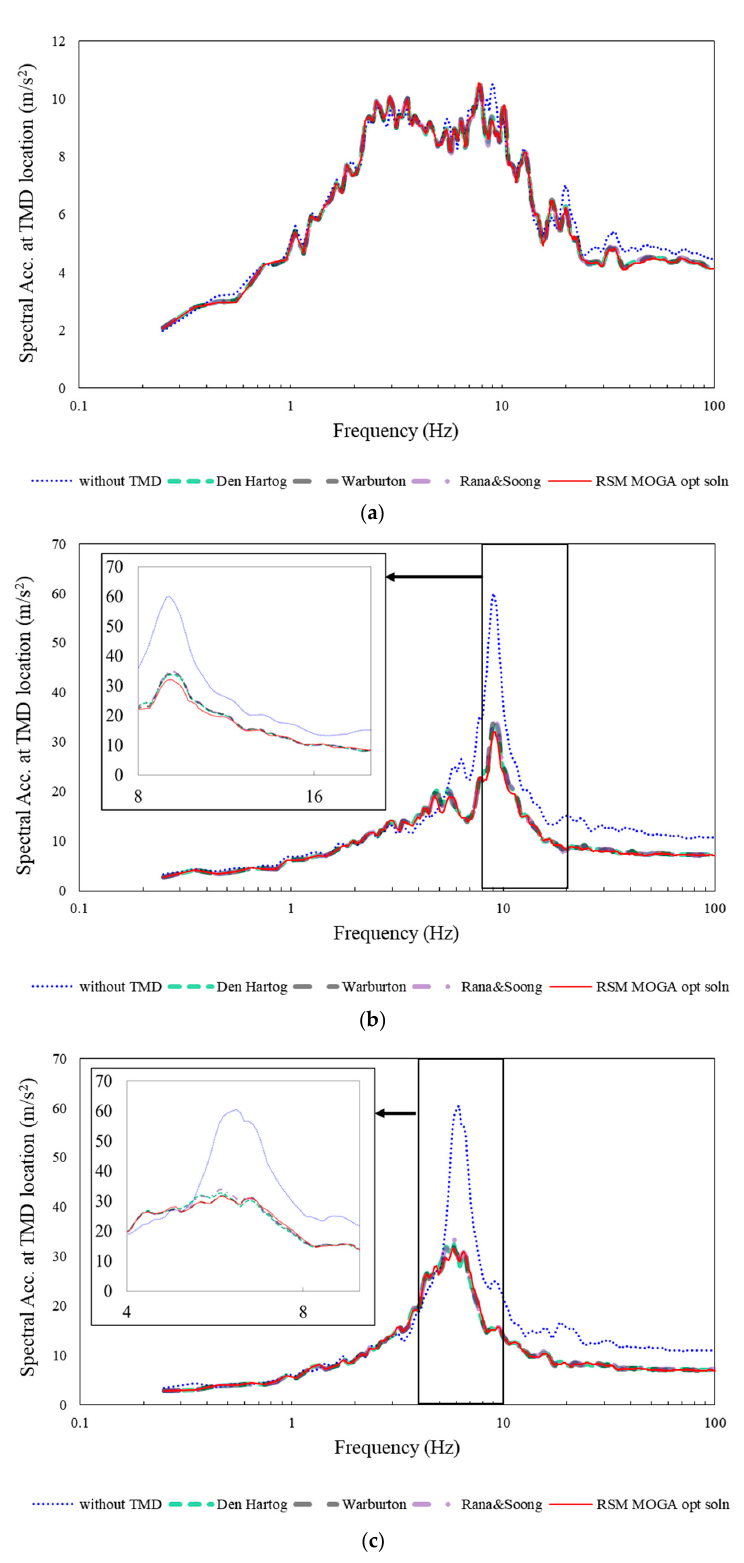
Figure 12. Comparison of the response spectra of directional acceleration responses at the TMD installation location of the piping: ( a ) X-direction spectrum (5%); ( b ) Y-direction spectrum (5%); ( c ) Z-direction spectrum (5%).